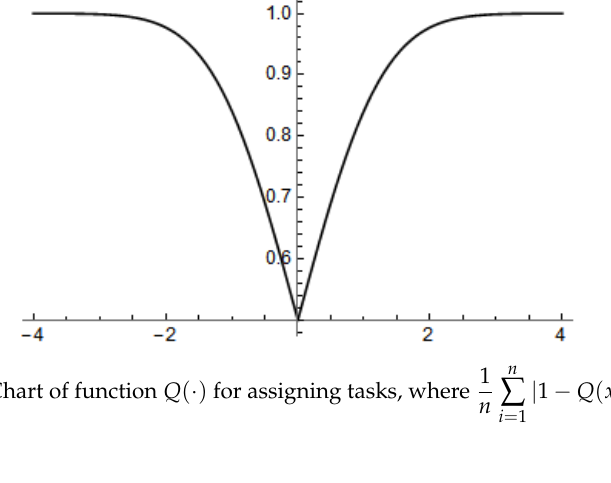
Figure 3. Chart of function Q ( · ) for assigning tasks, where